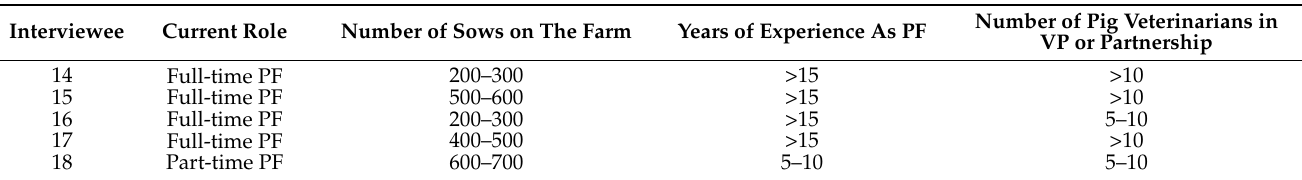
Table 2. Details of participants (farmers) interviewed in the study: “Why Veterinarians (Do Not) Adhere to the Clinical Practice Streptococcus suis in Weaned Pigs Guideline: A Qualitative Study”.